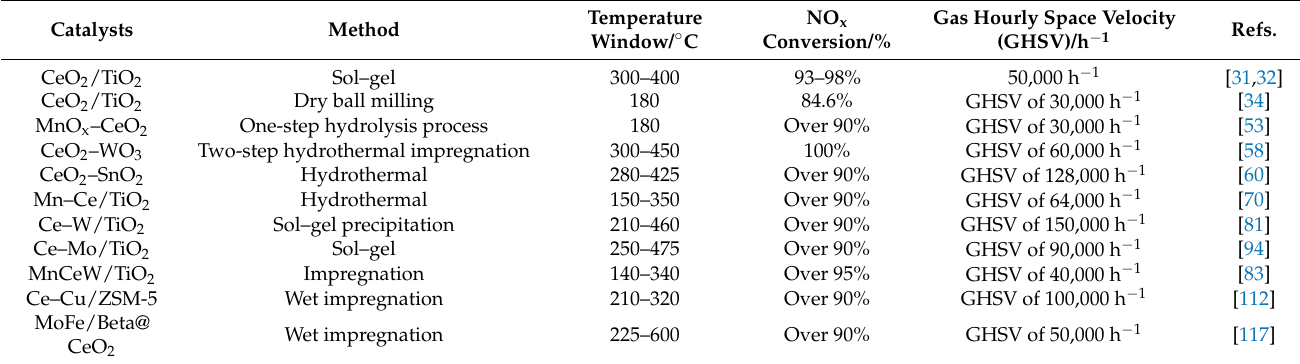
Table 1. The denitration performance of different